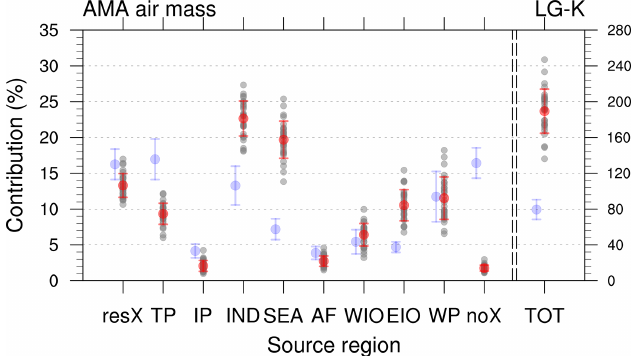
Figure B3. Contributions of PBL sources to the AMA around 150hPa for the LG-K simulation for 1981–2010 (with 2008 removed; see text for details). Mean values are given as red dots, red whiskers denote the interannual standard deviation and individual years are indicated as grey dots. For TOT the right axis denotes the total number of trajectories in units of 10 3 trajectories. For comparison, faint blue dots and whiskers denote the values from the TRJ data.